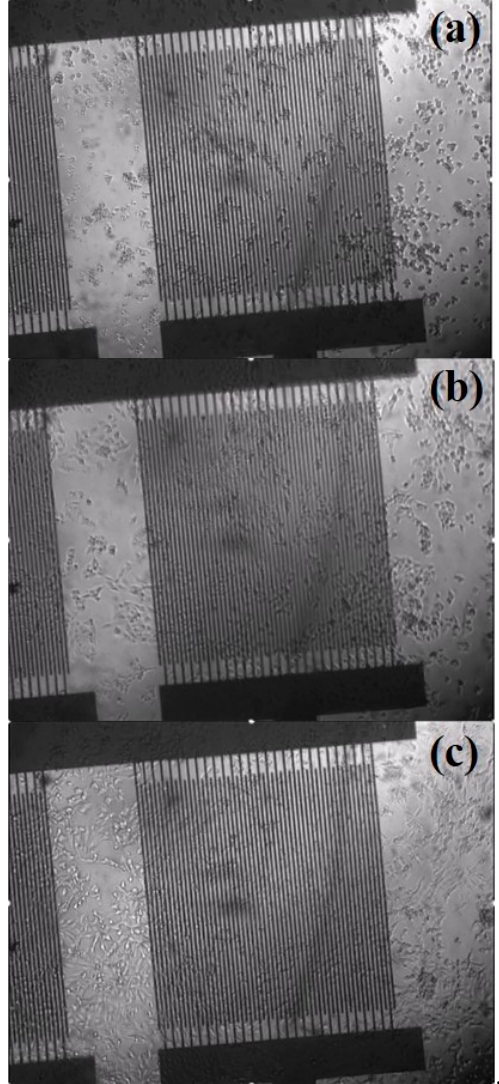
Figure 3. Time-lapse images of cell attachment and spreading on the on-chip platform for ECIS proliferation assays: ( a ) at the beginning of the HLF proliferation assay, immediately after the cell seeding; ( b ) during the exponential growth phase; ( c ) semi-confluent monolayer acquired 45 h post seeding.